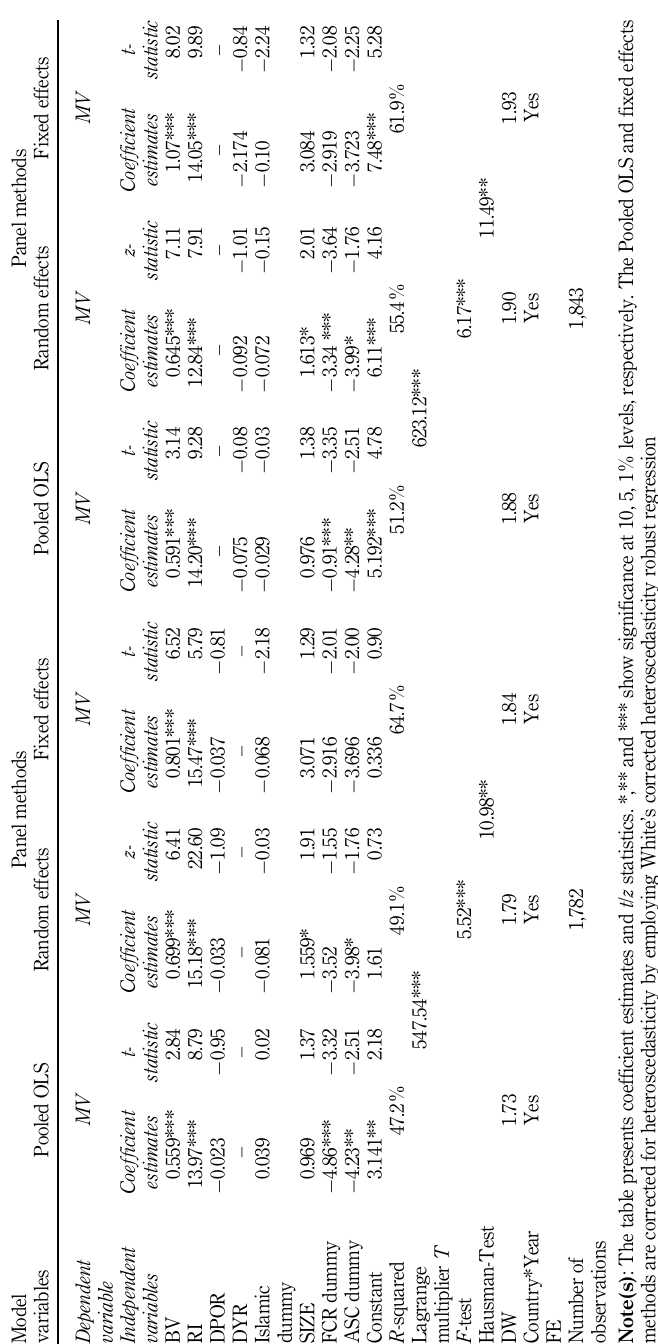
Table 5. Findings of the